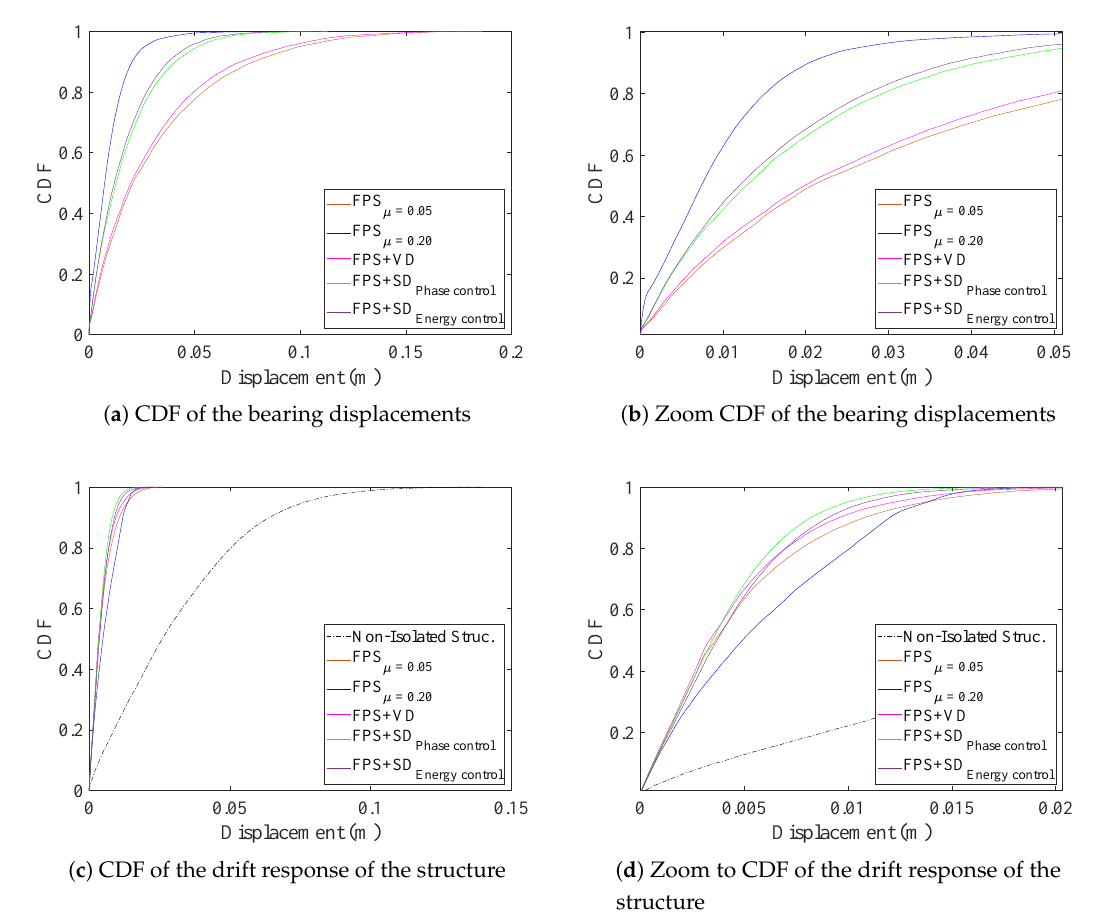
Figure 13. Cumulative distribution function (CDF) of bearing plate displacement and drift under the design